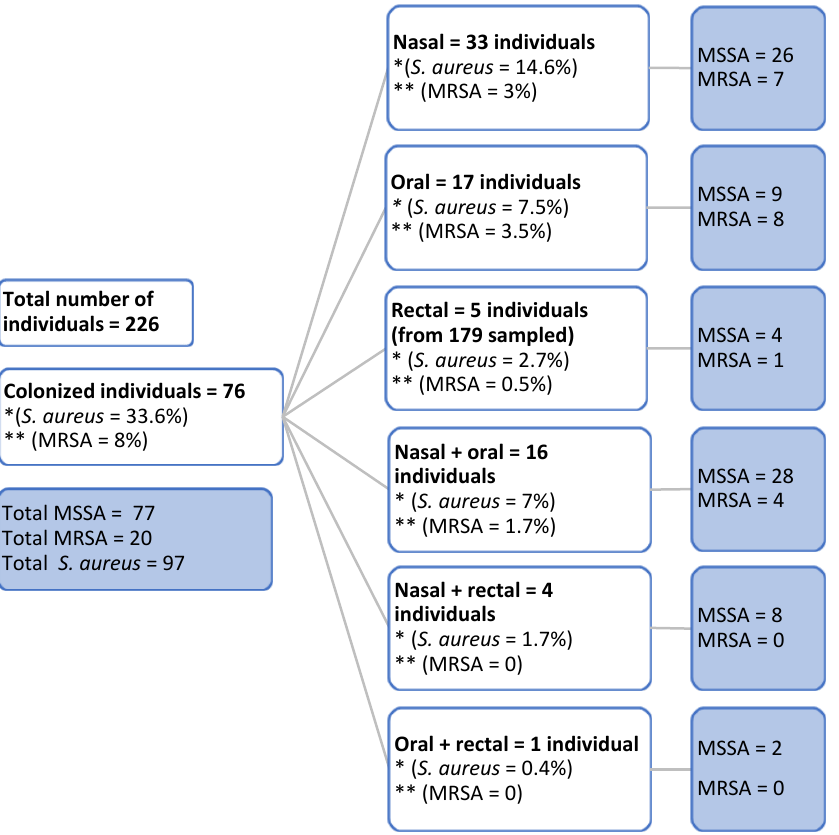
Figure 1. Flow chart of the total number of individuals colonized with S. aureus and number of individuals colonized with methicillin-susceptible S. aureus (MSSA) and methicillin-resistant S. aureus (MRSA) according to the sampling site. Note: Total number of individuals included in the study (226), number of individuals colonized with S. aureus (76), and number of colonized individuals according to the sampling site. * Overall prevalence of S. aureus . ** Overall prevalence of MRSA.